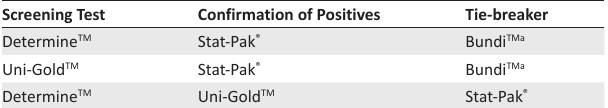
TABLE 3: National interim serial HIV rapid testing algorithm implemented in 2007. Screening